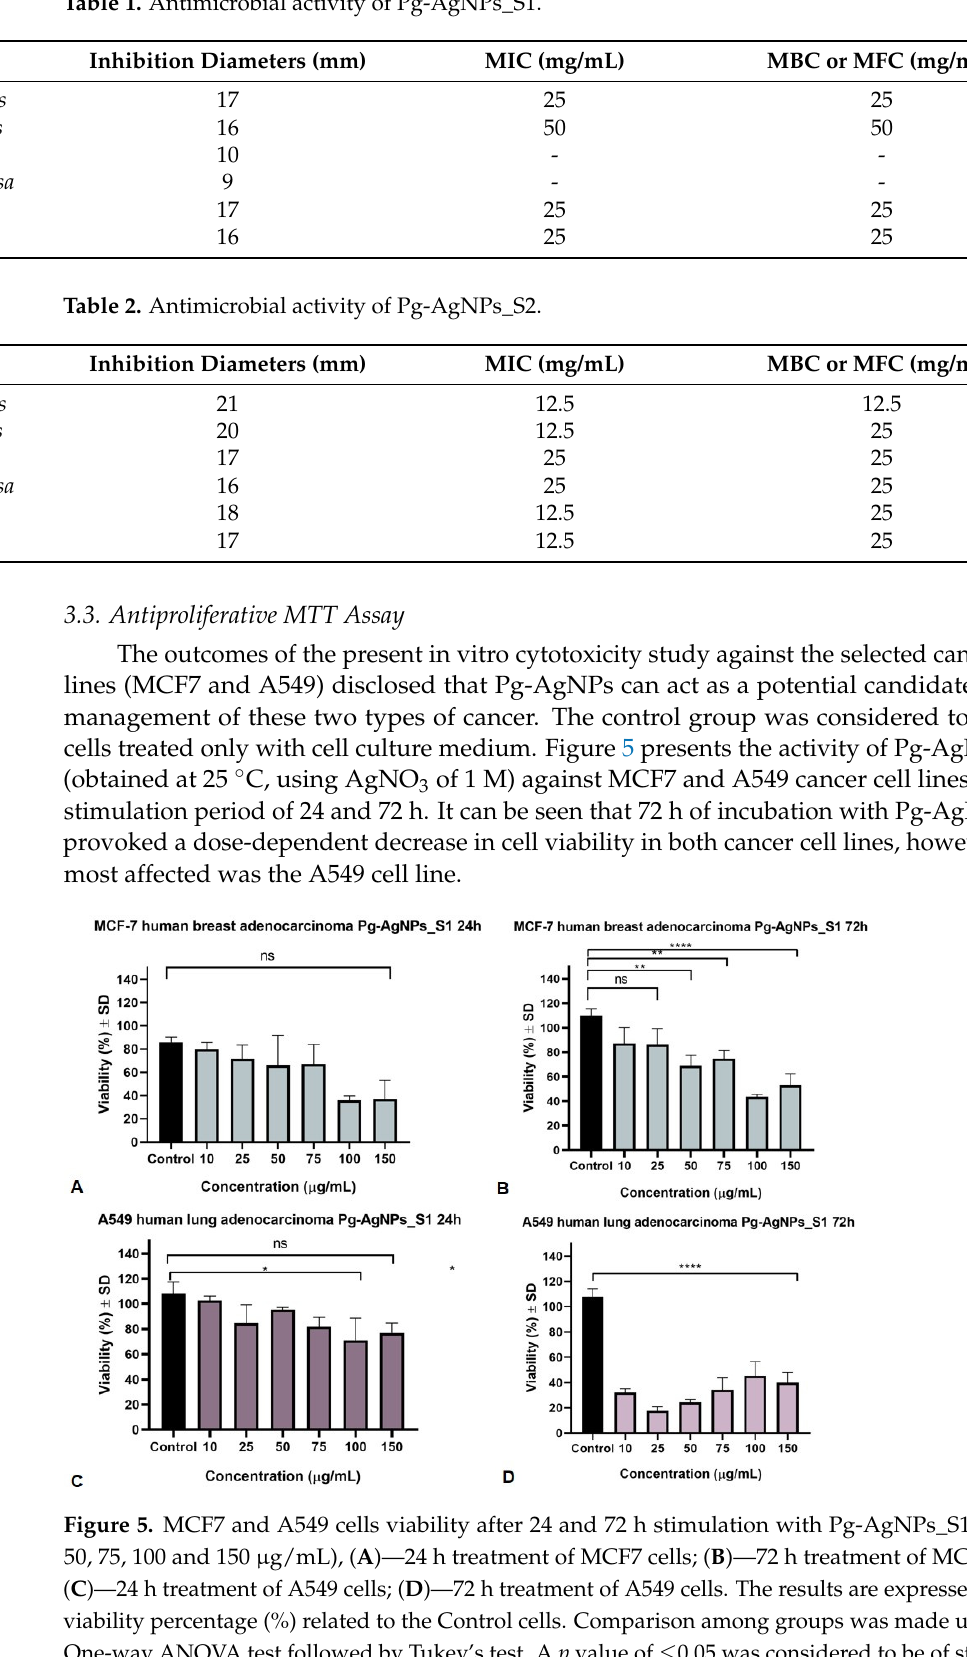
Figure 6. MCF7 and A549 cells viability after 24 and 72 h stimulation with Pg-AgNPs_S2 (10, 25, 50, 75, 100 and 150 µg/mL). ( A )—24 h treatment of MCF7 cells; ( B )—72 h treatment of MCF7 cells; ( C )— 24 h treatment of A549 cells, ( D )—72 h treatment of A549 cells. The results are expressed as cell viability percentage (%) related to the Control cells. Comparison among groups was made using the one-way ANOVA test followed by Tukey’s test. A p -value of ≤ 0.05 was considered to be of statistical significance (* p ≤ 0.05; ** p ≤ 0.01; **** p ≤ 0.0001).